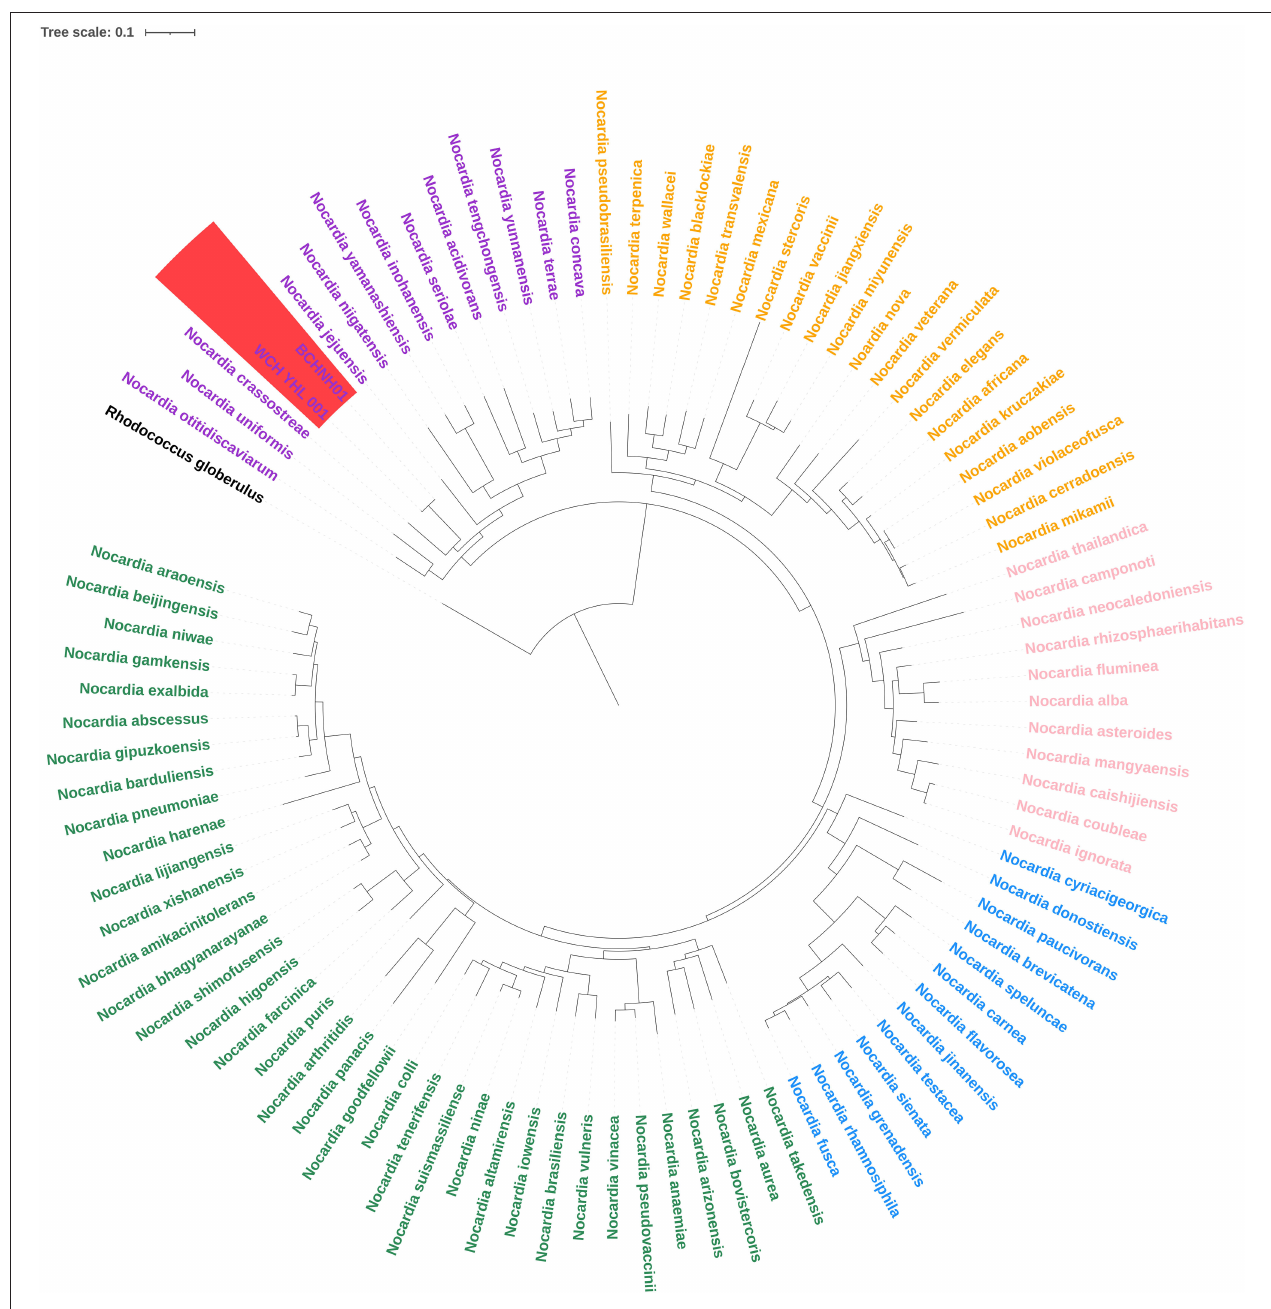
FIGURE 3 | Phylogenomic tree was constructed based on the dapb1